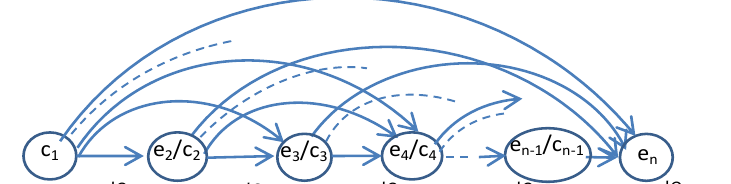
Figure 4. Apply the transitive closure on a correct extracted causal pathway started with c j + t = c 1 where j = 1; t = 0, 1, 2, … , n − 1.